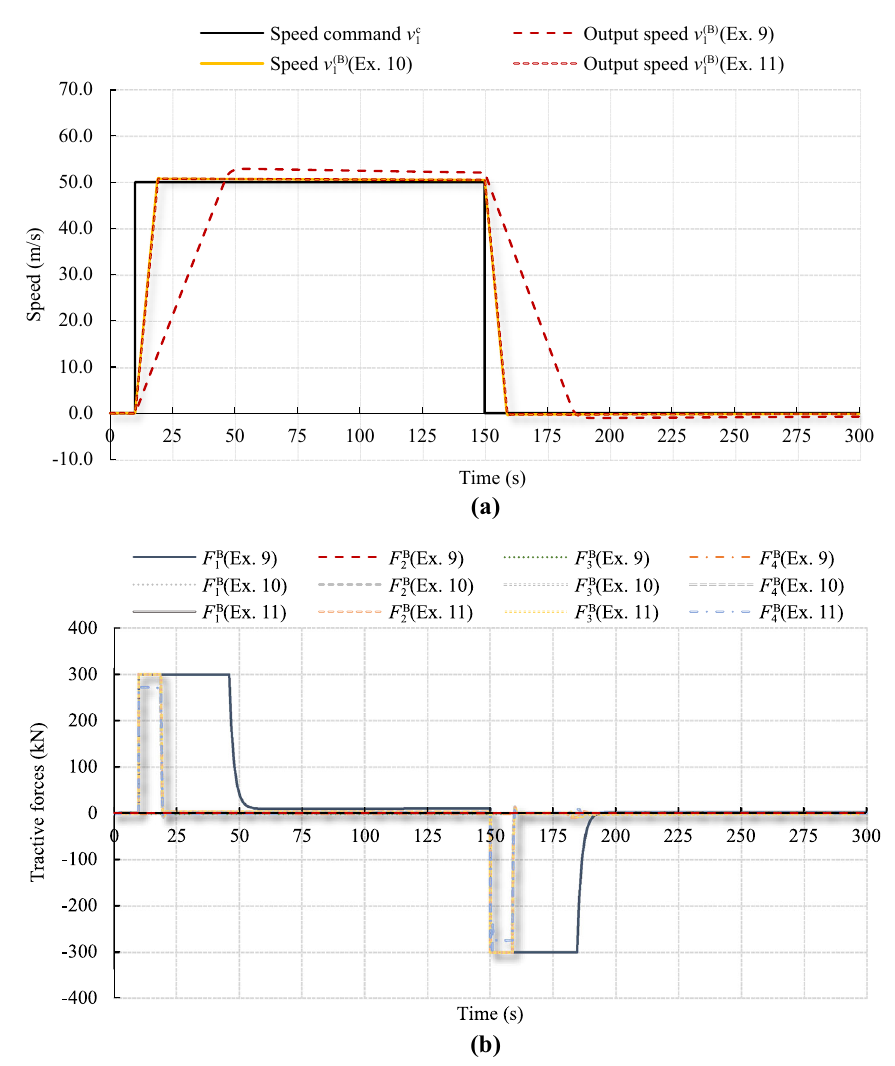
Fig. 15 Simulation results based on the LTD for model B of the MUT: a train speed _ x 1 vs. time; b tractive forces F B passive vibration damping is only used; in Ex. 11 both passive and active vibration damping are